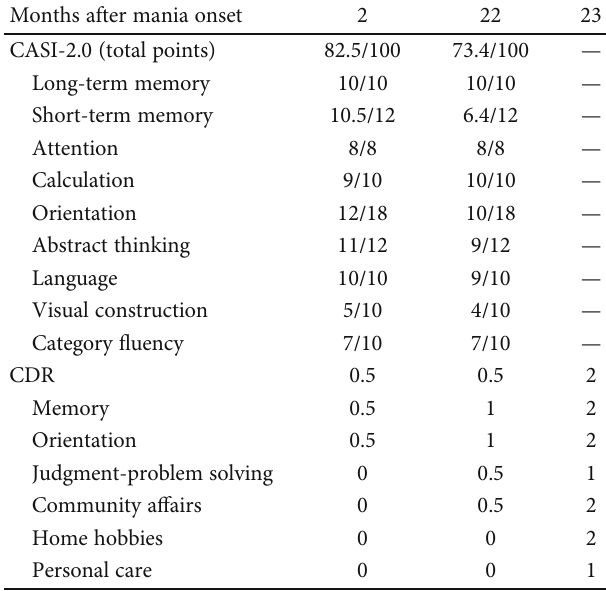
The results were rated by clinical psychologists using the standardized Mandarin version of the cognitive abilities screening instrument-2.0 (CASI-2.0) and clinical dementia rating scale